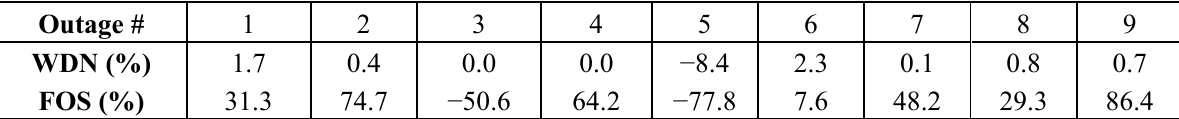
Table 6. Summary of percentage position improvement during GPS outages (Road Test